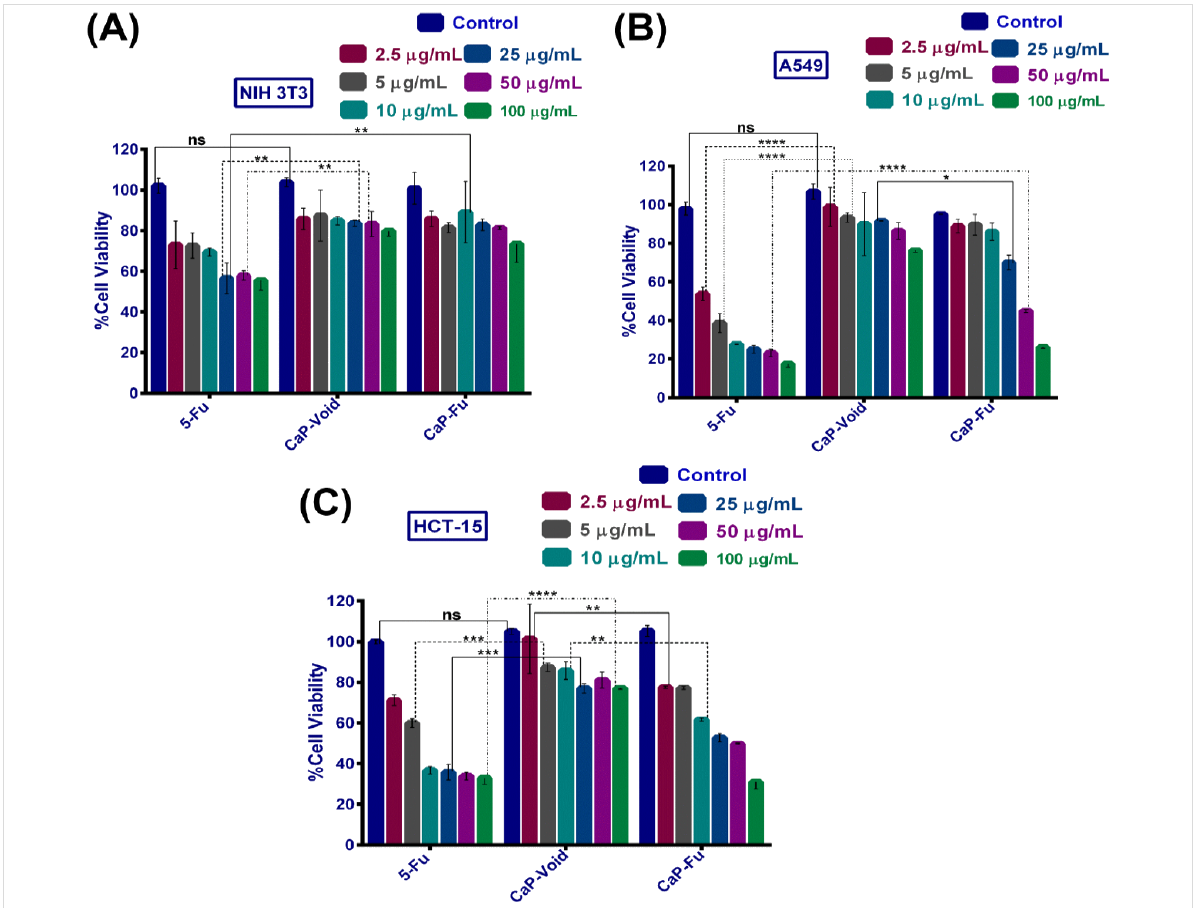
Figure 4: Analysis of cell viability by MTT assay for (A) NIH 3T3, (B) A549 and (C) HCT-15 cells upon CaP@5-FU NP, CaP NP and 5-FU treatment for 24 h. Two-way analysis of variance (ANOVA) followed by Tukey’s multiple comparison test were performed for the statistical significance assess- ment between the mean of the group (* p < 0.05, ** p < 0.005, *** p < 0.001, ns – non